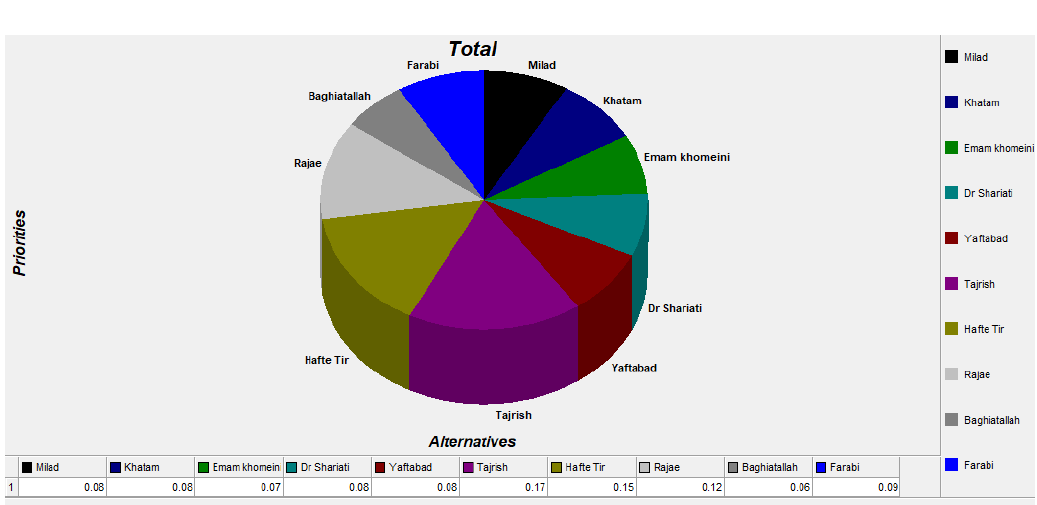
Figure 3. Ranking of hospitals with expert choice